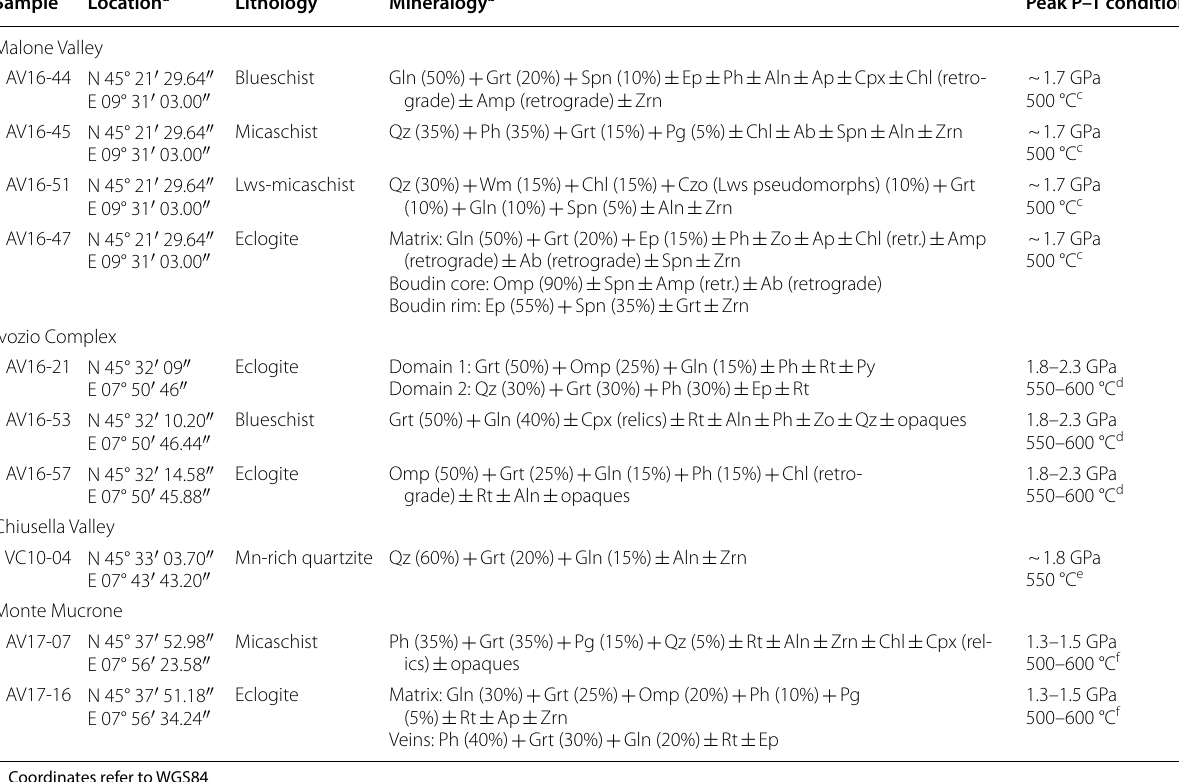
Table 1 List of the analysed samples. Mineral abbreviations are from Whitney and Evans